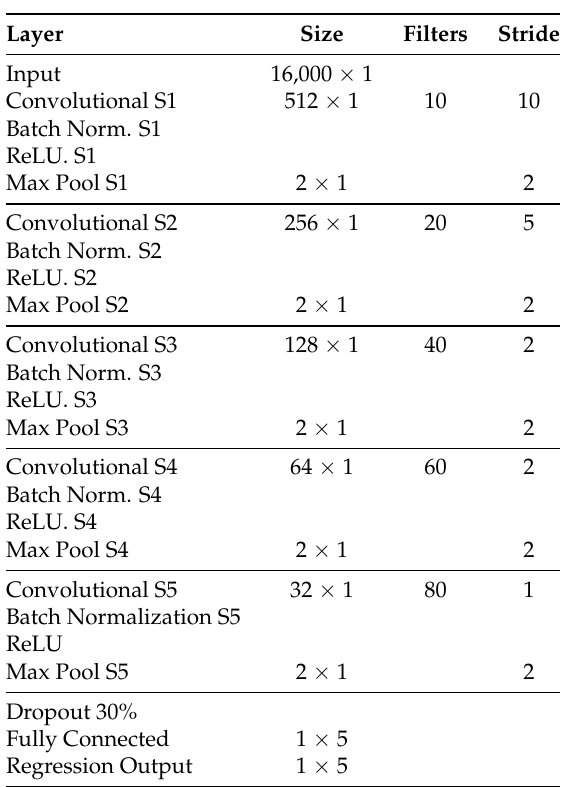
Table 3. CNN layer